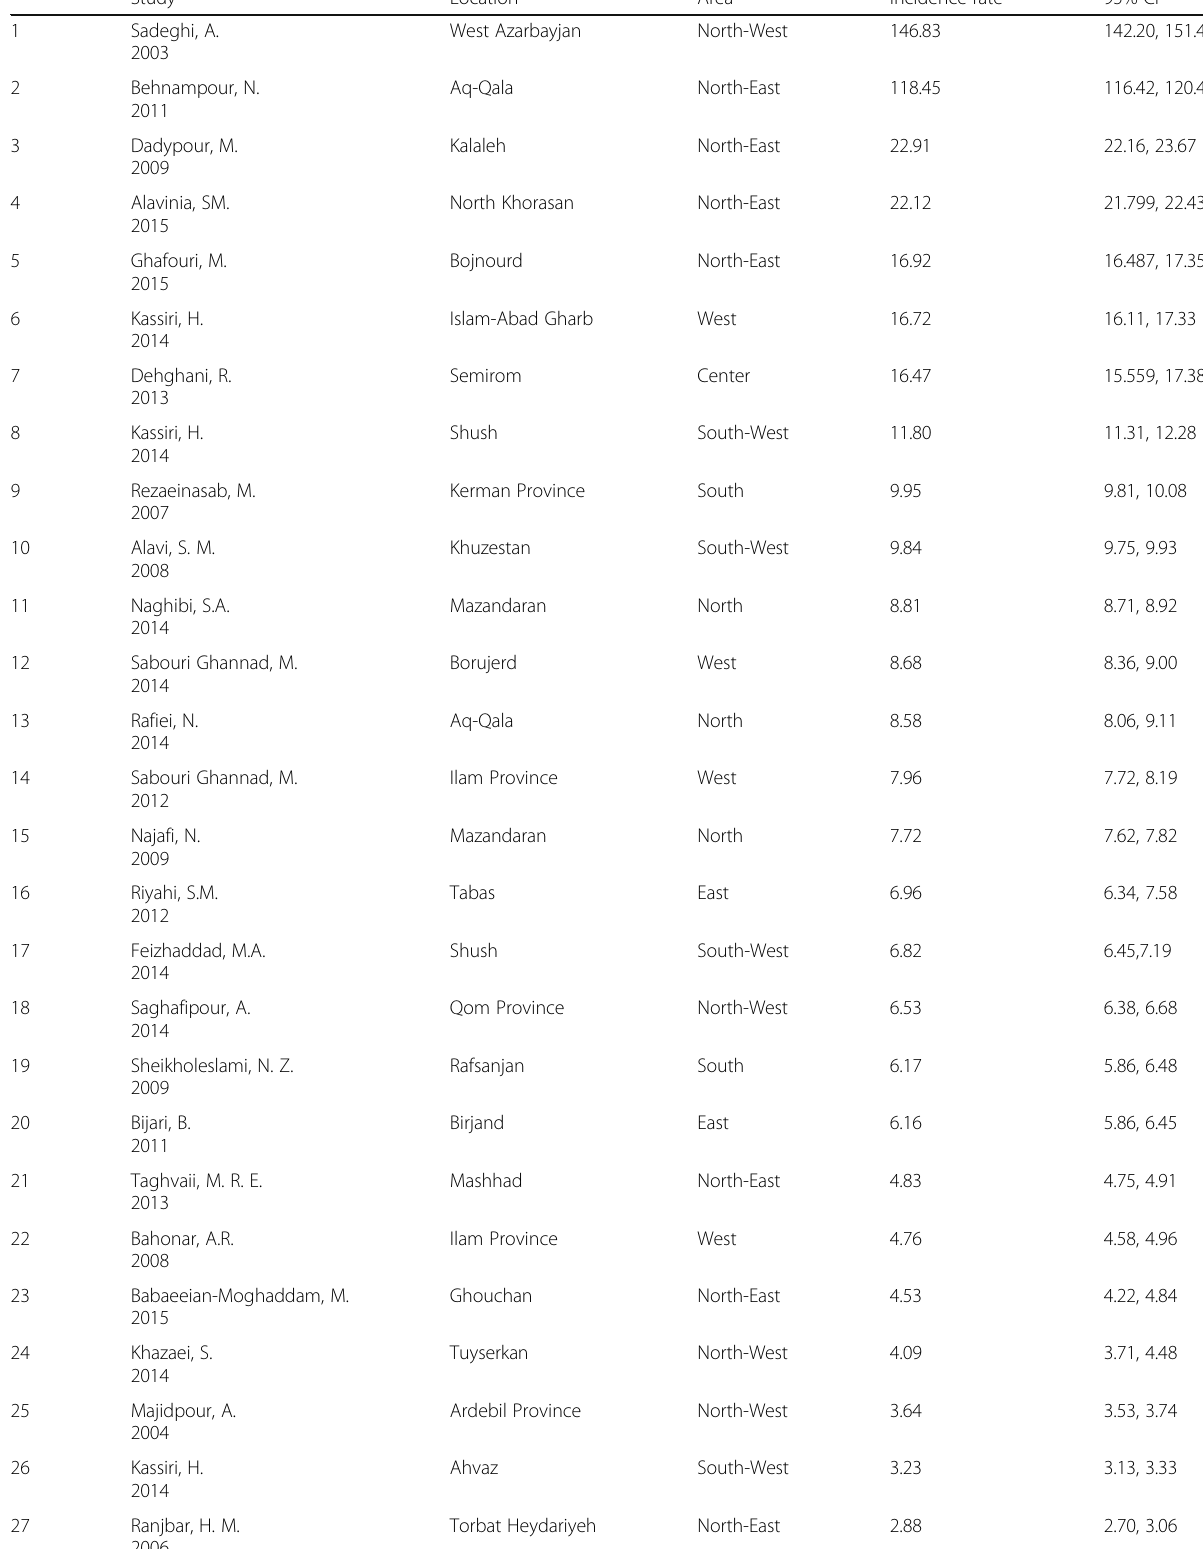
Table 3 The incidence rates of studies in descending order